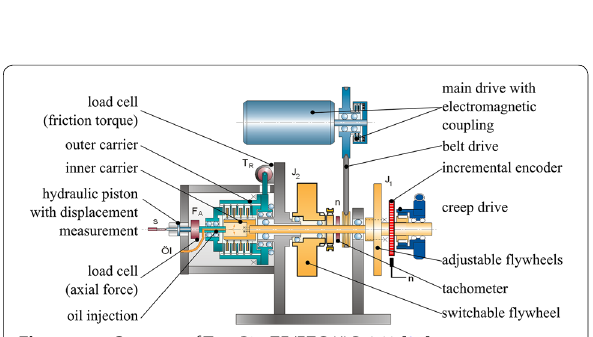
Figure 11 Concept of Test Rig ZF/FZG KLP-260 [37]